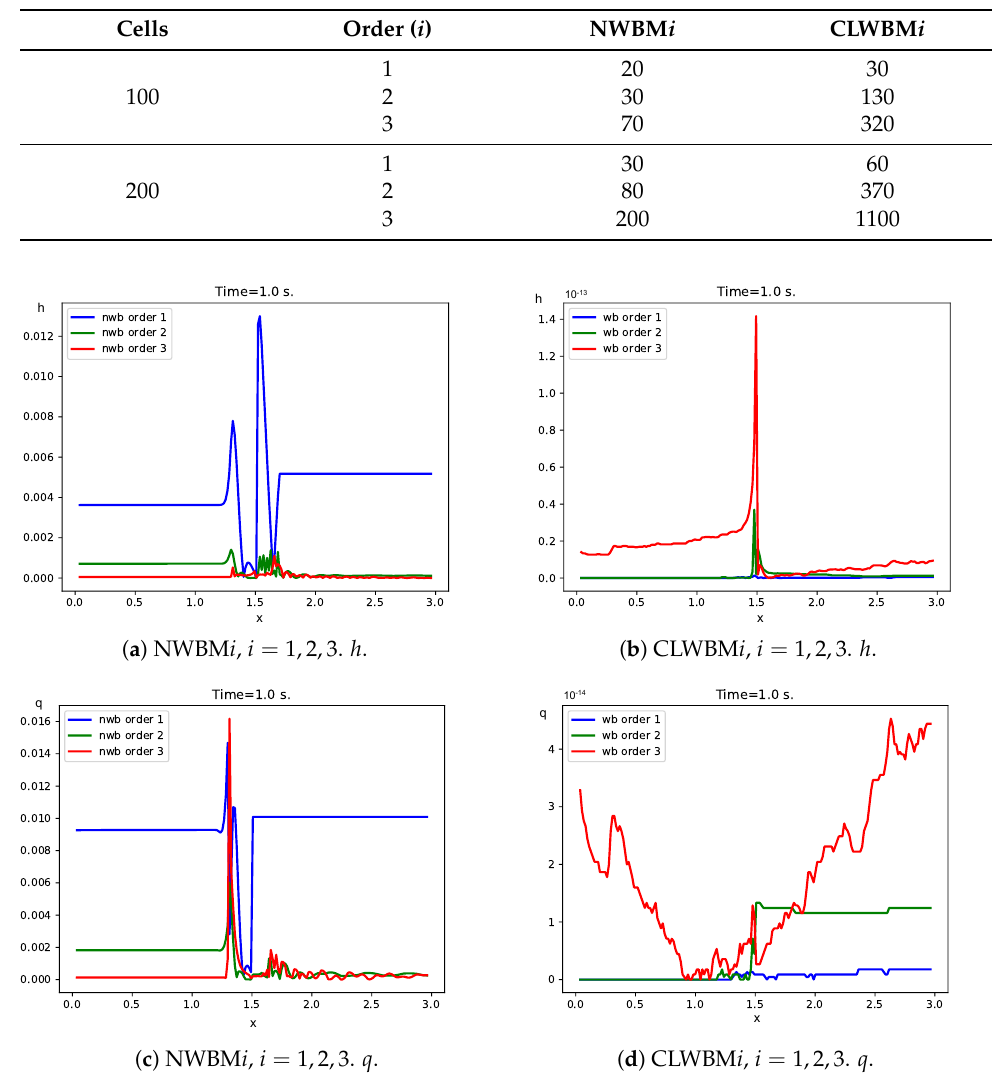
Figure 4. Test 3.1. Reference and numerical solutions: differences with the stationary solution at time t = 1 s for the 200-cell